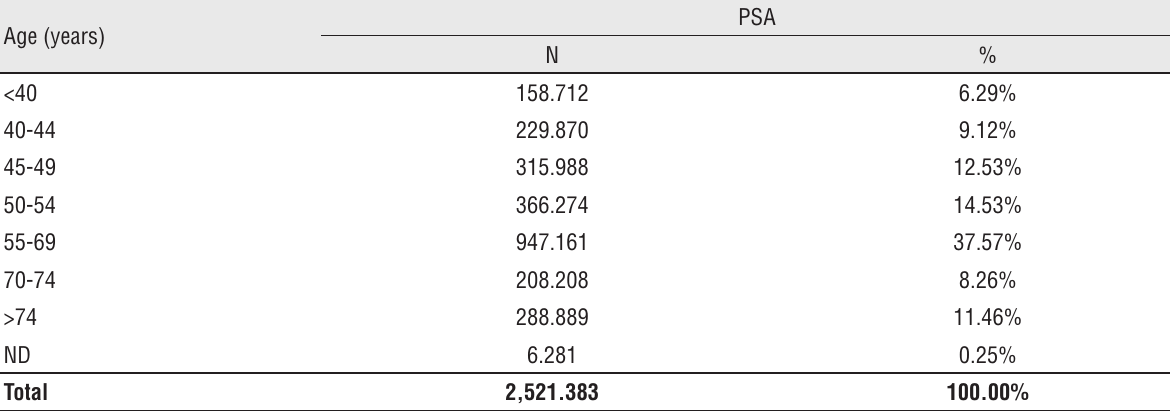
Table 2 - Age distribution of men undergoing PSA